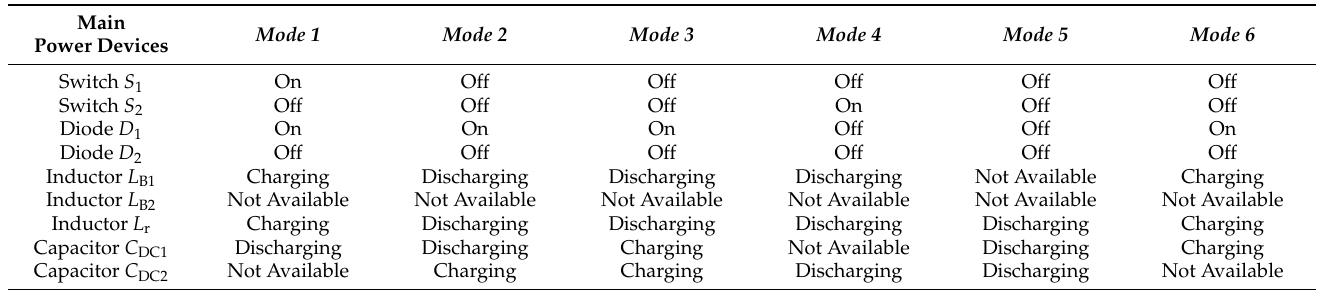
Table 2. States of the main power devices in each operational mode during the positive half-cycle of the utility-line voltage. Main Power Devices